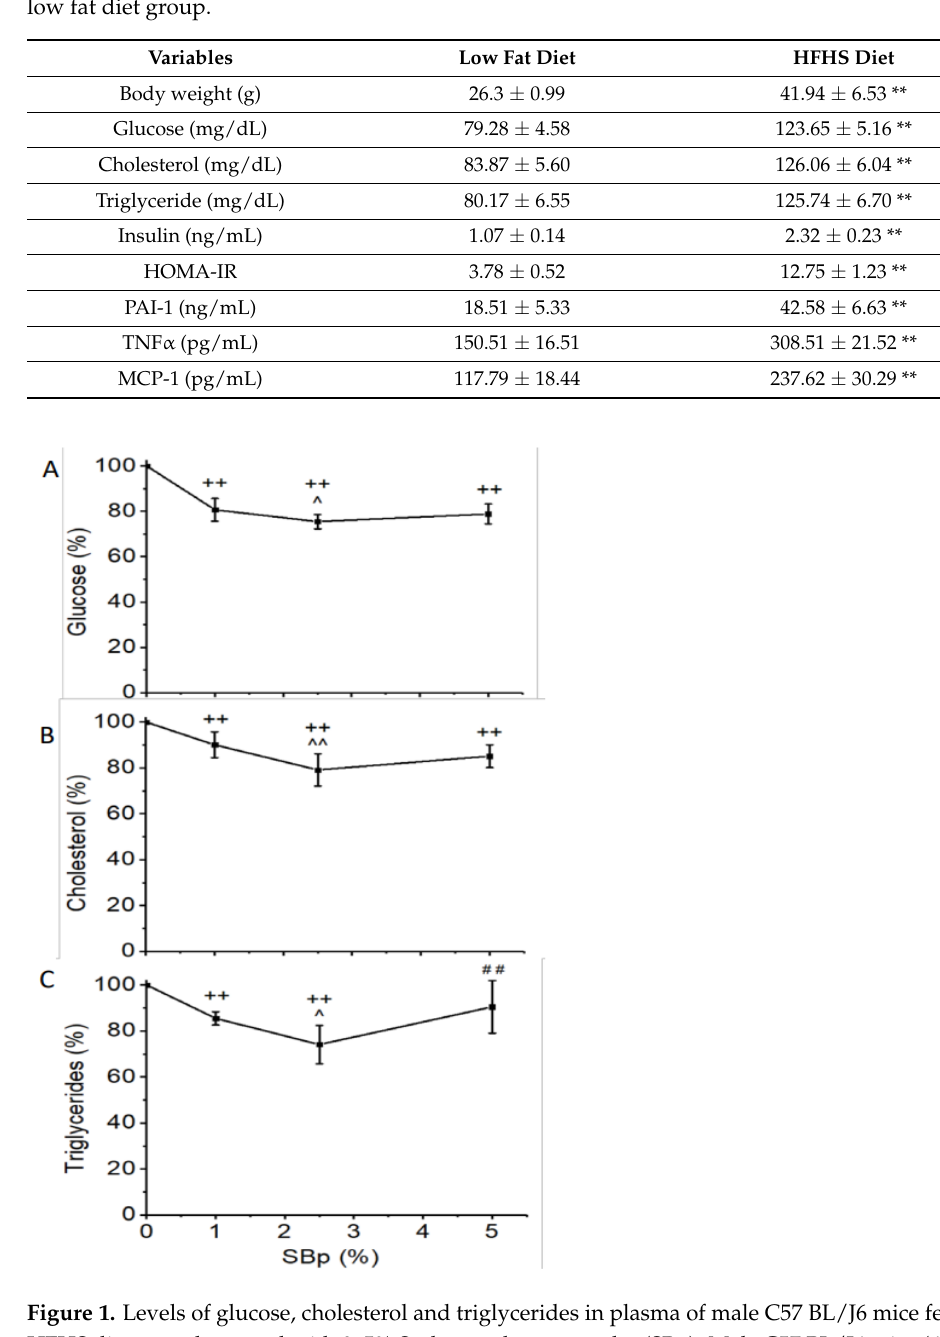
Figure 1. Levels of glucose, cholesterol and triglycerides in plasma of male C57 BL/J6 mice